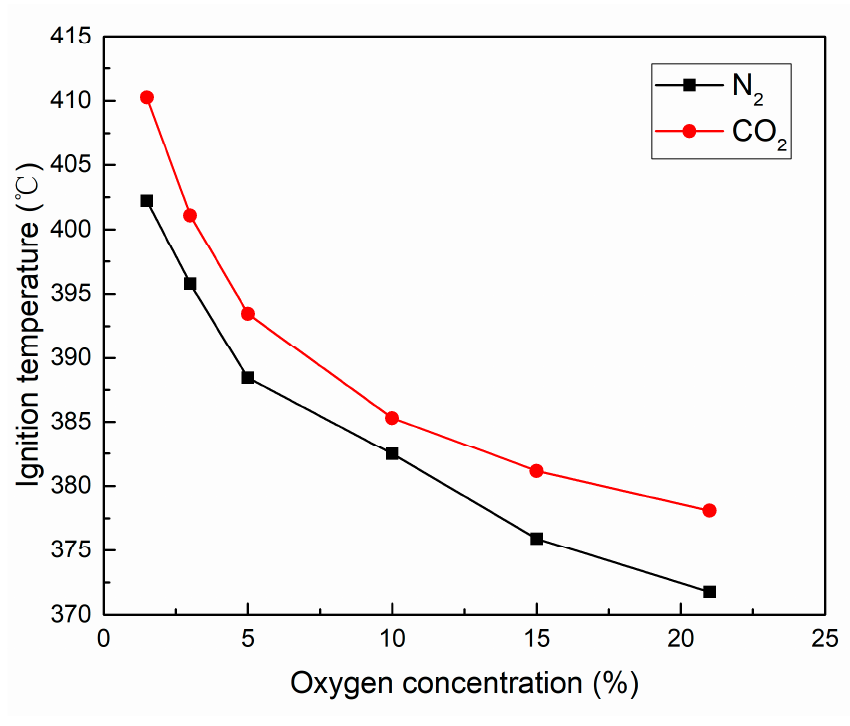
Figure 9. Ignition temperature of coal sample in the N 2 and CO 2 atmospheres.